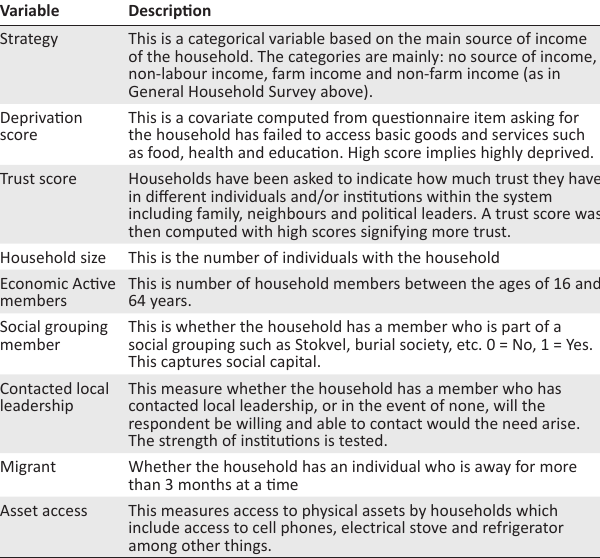
TABLE 11: Variable description.